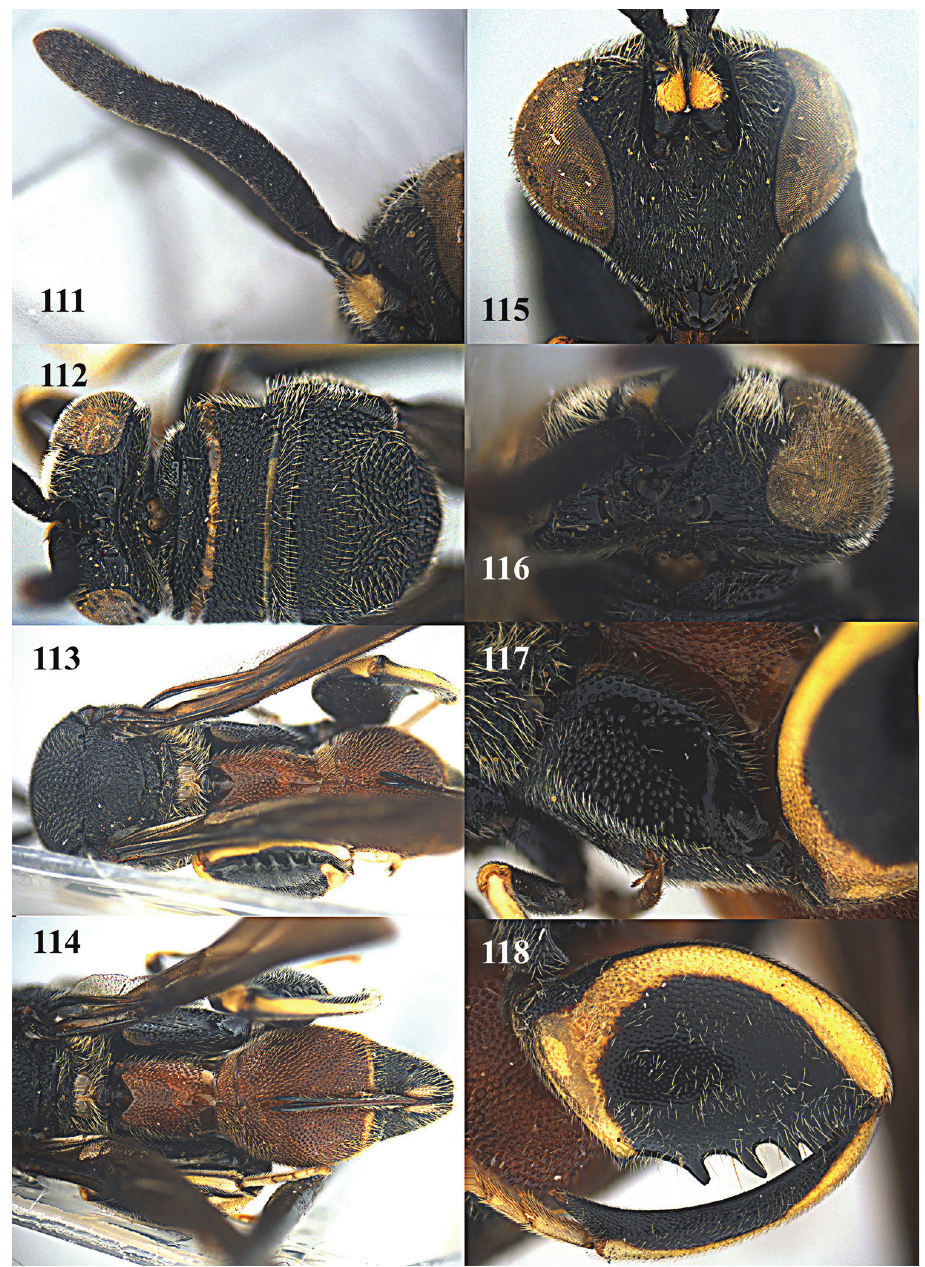
Figures 111–118. Leucospis petiolata Fabricius, ♀ from Guangdong, Nanling. 111 Antenna 112 head and pronotum dorsal 113 mesosoma and metasoma dorsal 114 propodeum and metasoma dorsal 115 head frontal 116 head dorsal 117 hind coxa 118 hind femur and